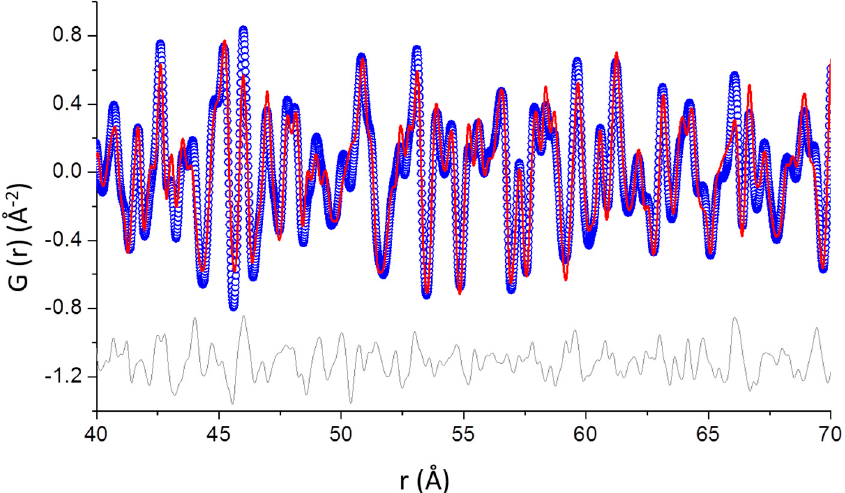
Figure 2. Experimental pair distribution function (PDF) patterns from 1.5 to 10 Å for alite, calcium aluminate, and ye’elimite pastes.